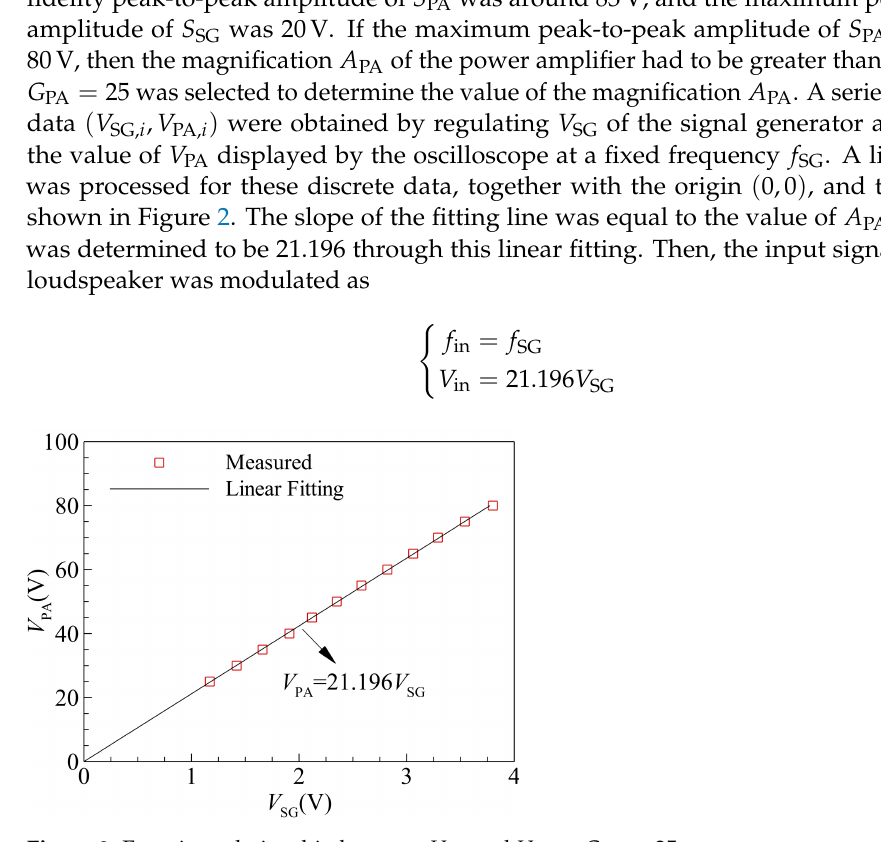
Figure 2. Function relationship between V PA and V SG at G PA =